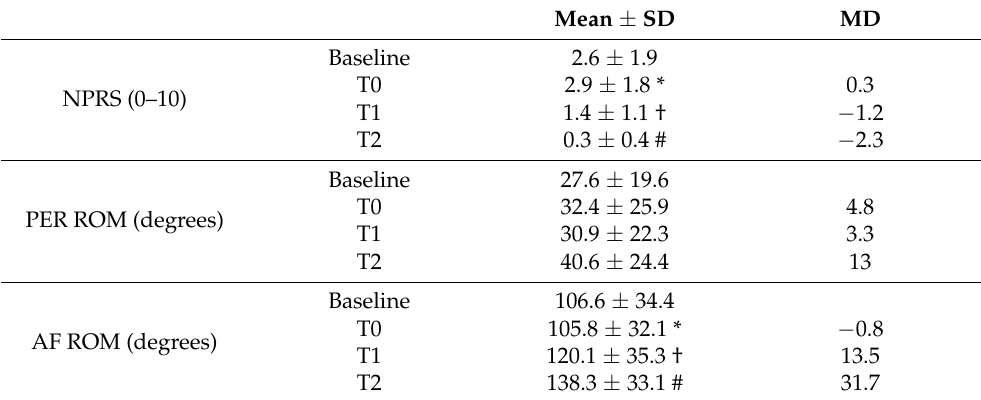
Table 3. Self-reported shoulder pain and range-of-motion outcomes at baseline, two-week “washout” period (T0), posttreatment (T1), and follow-up (T2). Mean ± SD MD Baseline NPRS (0–10)